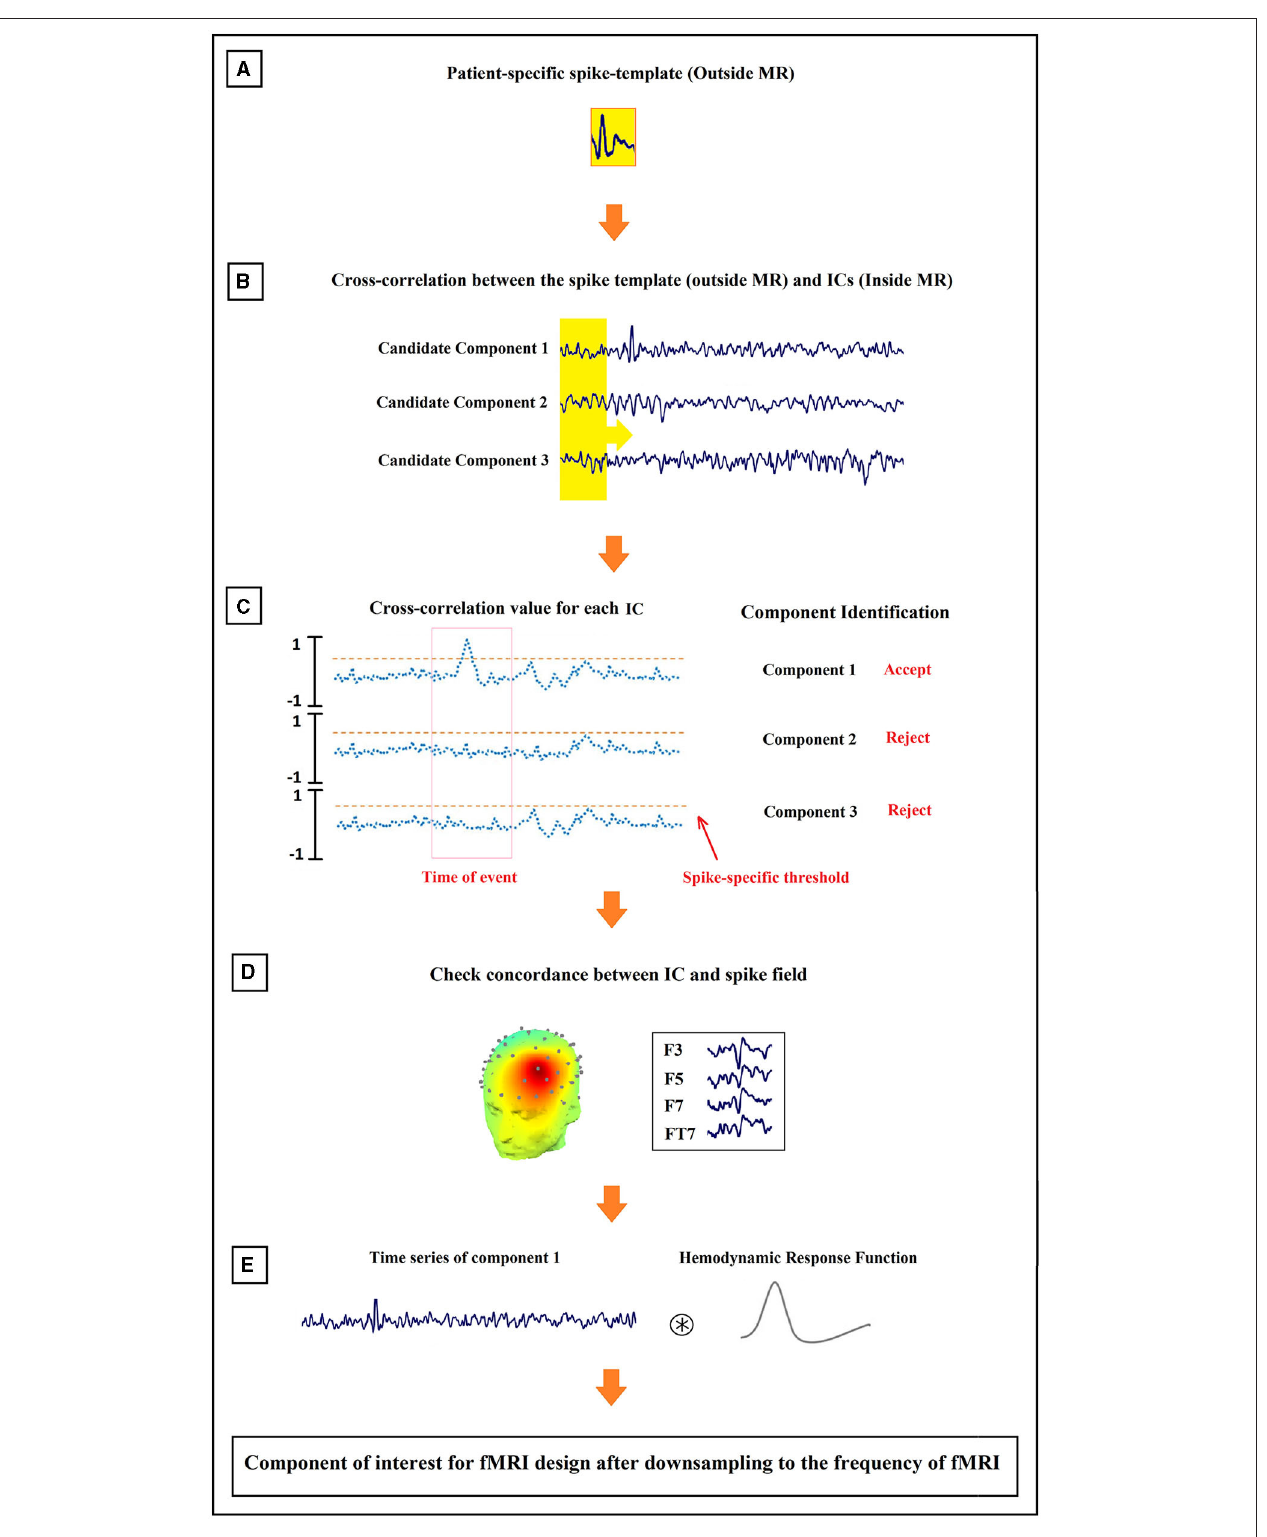
FIGURE 4 | Schematic illustration of the method proposed for the identification of epilepsy-related components. The order of the process from (A–E) is shown in the figure.